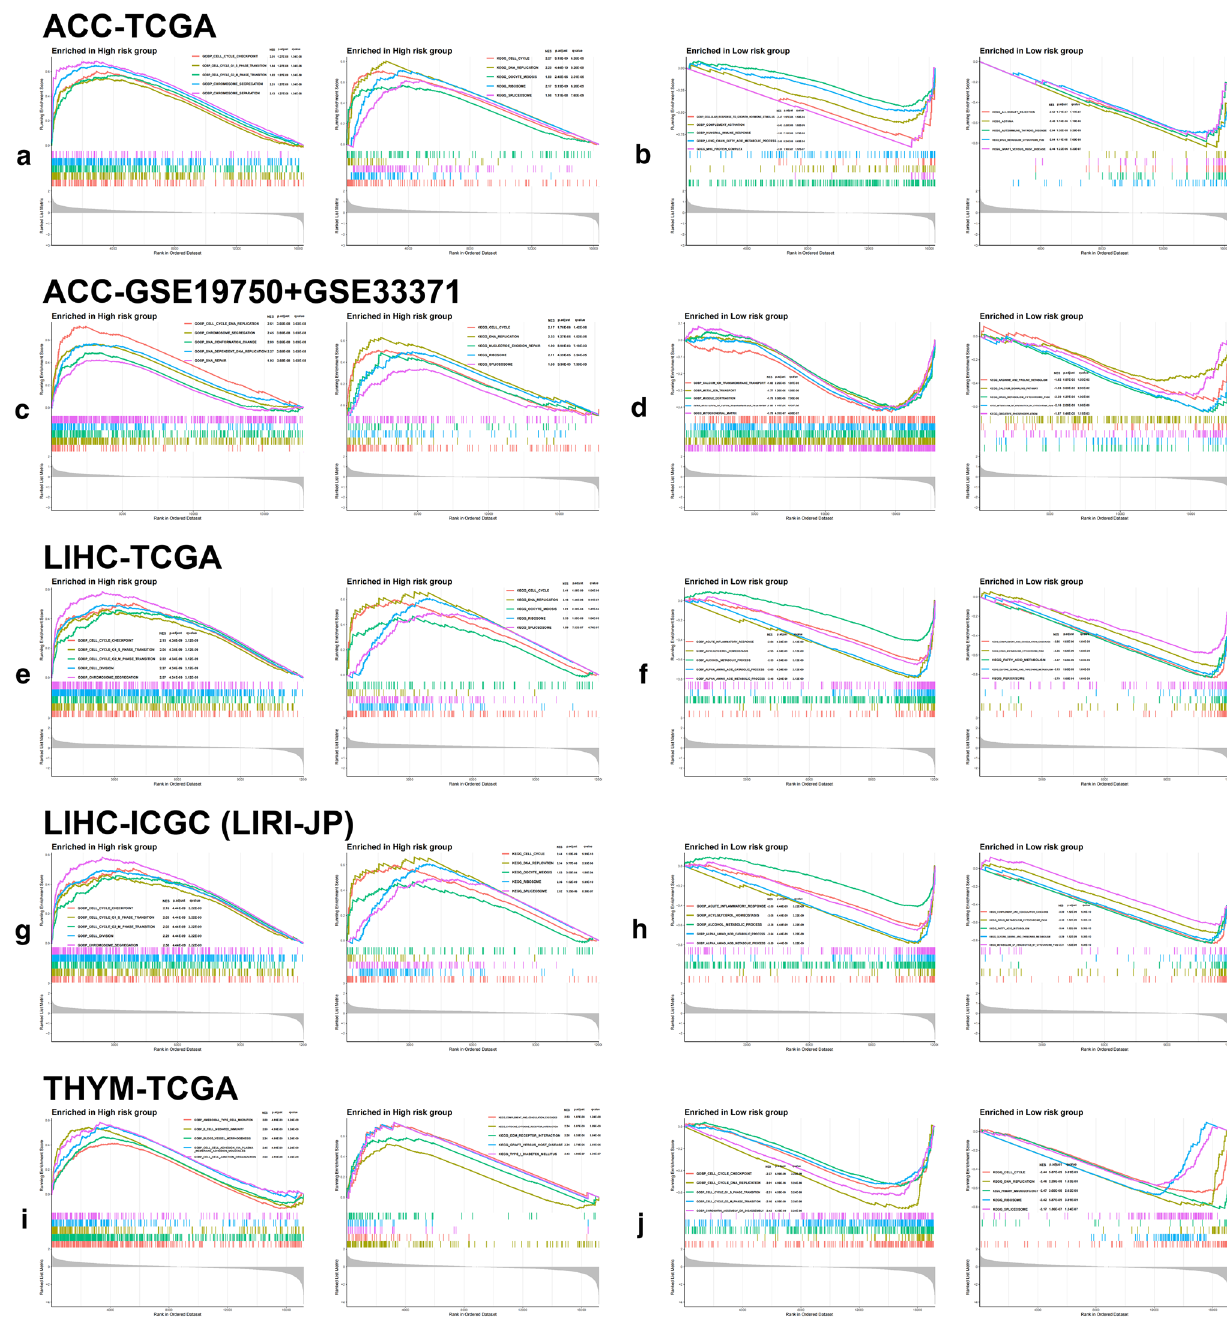
Fig. 7 Gene Set Enrichment Analyses (GSEA) in ACC, LIHC and THYM. GSEA shows the top 5 gene ontology (GO) and Kyoto Encyclopedia of Genes and Genomes (KEGG) pathways enriched in low- and high-risk groups of ACC ( a – d ) and LIHC ( e – h ) at both training and testing sets. For THYM ( i , j ), GSEA was only conducted in TCGA cohort. Normalized enrichment score (NES), adjusted p-value and q-value were marked in the patients from low-risk group and LIHC patients form high-risk group, higher mutation rate of mucin 16, cell surface associated (MUC16) was observed (Fig. 11b, d, e). In addition, isocitrate dehydrogenase (NADP(+)) 1 (IDH1), capicua